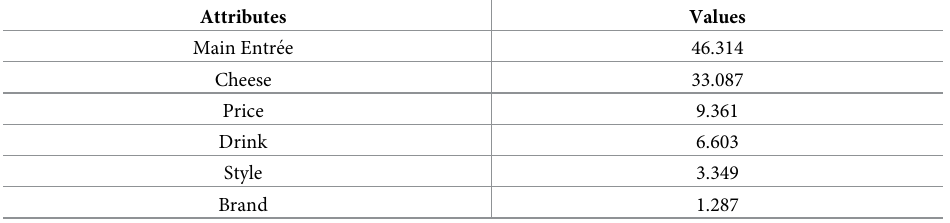
Table 6. Importance